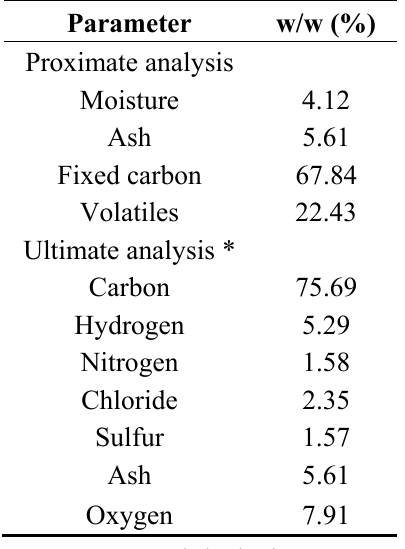
Table 1. Ultimate and proximal analysis of Guaduas Formation’s coal (HHV = 30,634 kJ kg − 1